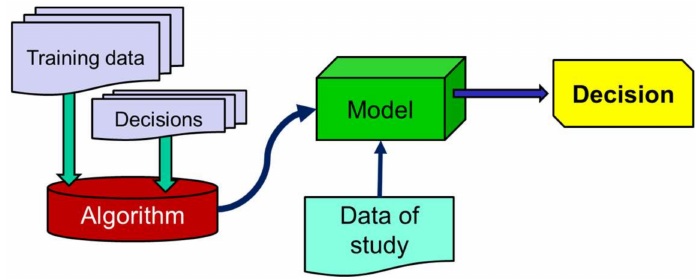
Figure 4. Typical Flow chart of a supervised learning classification